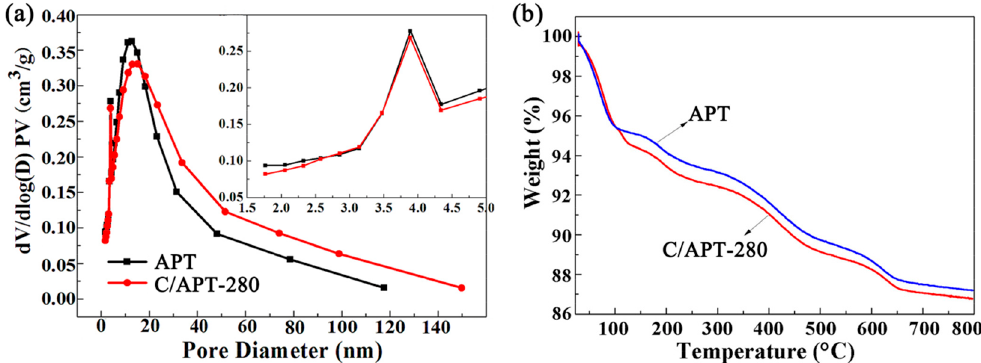
Figure 2. ( a ) Pore size distributions of APT and C/APT-280; and ( b ) TG curves of APT and C/APT-280 under an oxygen atmosphere.